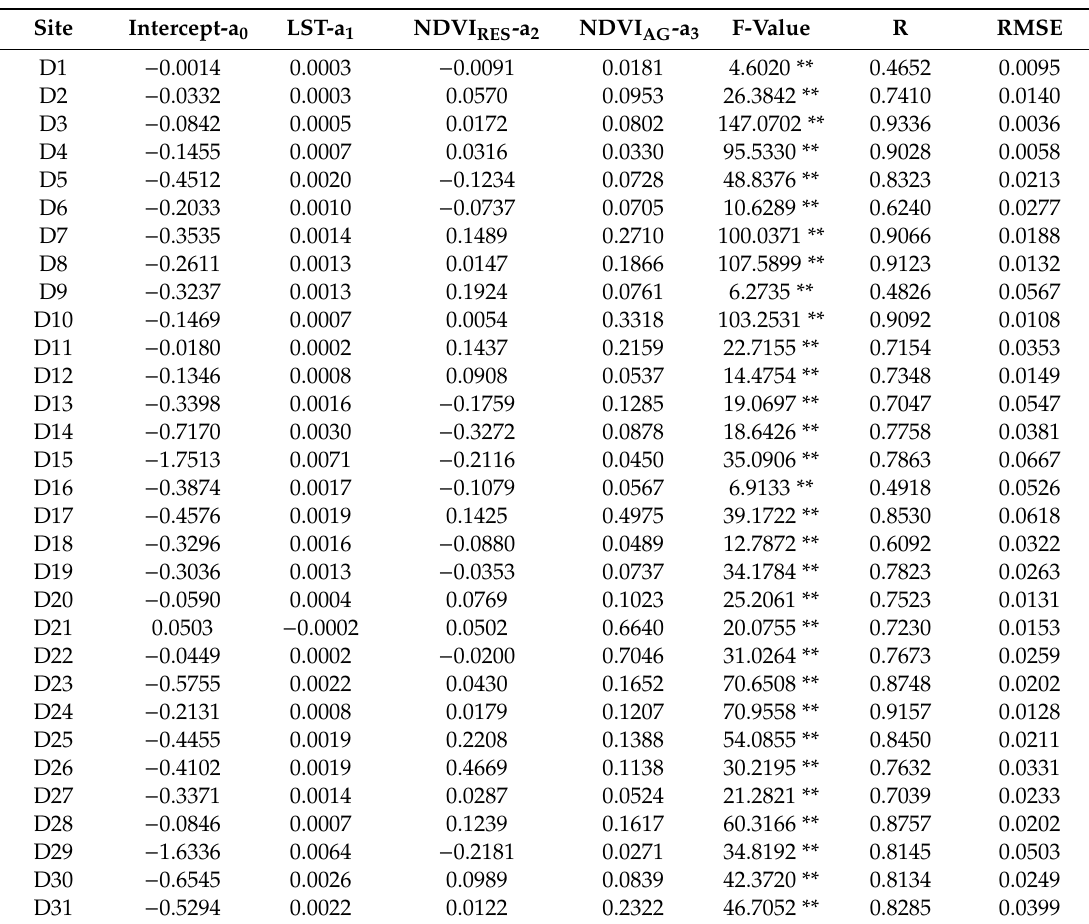
Table A3. Layer soil moisture estimation model (30–50